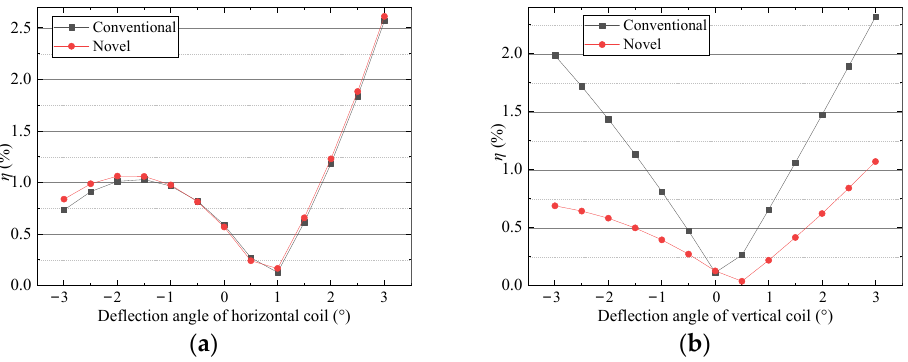
Figure 19. Ripple ratio versus deflection: ( a ) horizontal coil ( b ) vertical coil. The torque output of two schemes is compared by FEM under the current of 1 A, as shown in Figure 20. Because the horizontal force is higher than the vertical force, the torque in the z direction is larger than that in the x direction under the same current. The torque in the x direction of the improved scheme is 3.61 N·m, which is 7.4% higher than 3.36 N·m of the conventional one. The torque in the z direction of the improved scheme is 8.49 N·m, which is 5.6% higher than 8.49 N·m of the conventional one. So, the performance of torque output of the new halbach array is improved effectively.